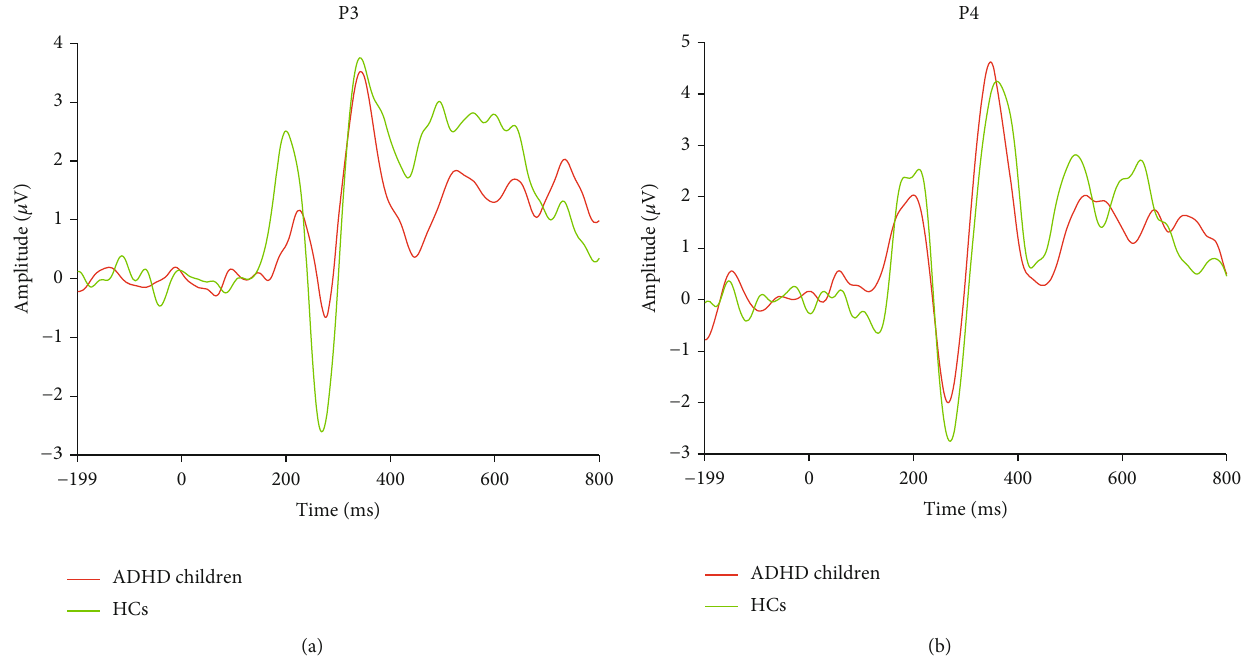
Figure 2: ERP waveforms at electrodes P3 (a) and P4 (b) between the HCs and ADHD